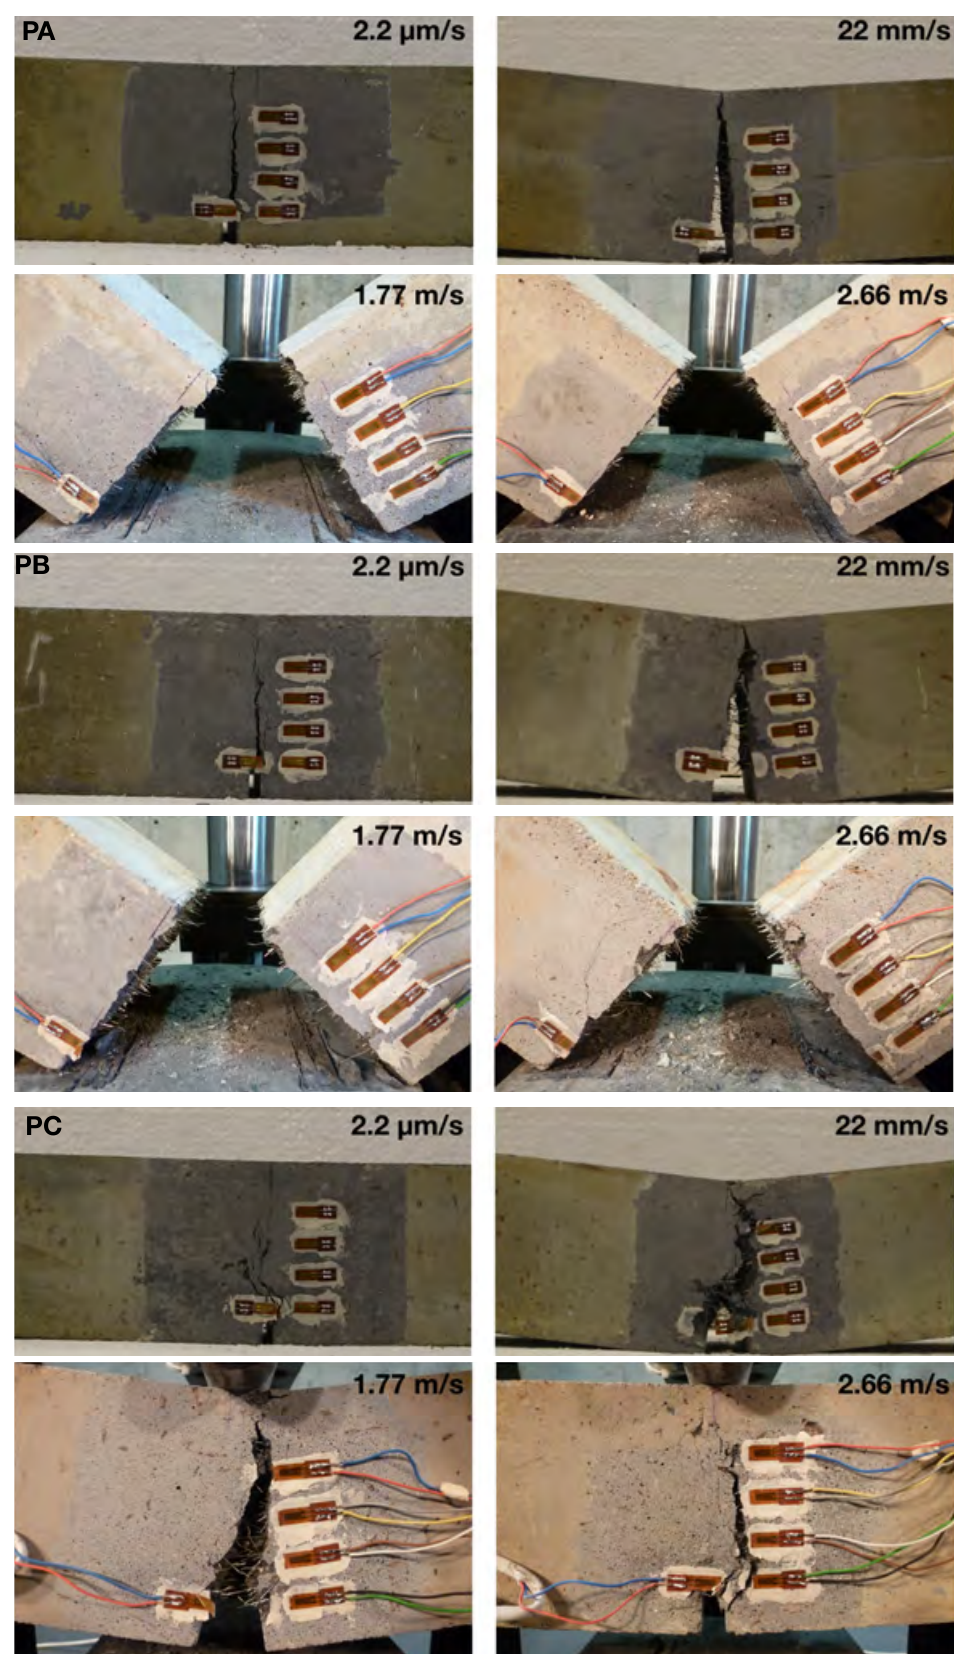
Figure 10. Typical failure modes of the PA, PB and PC beams loaded under four different loading